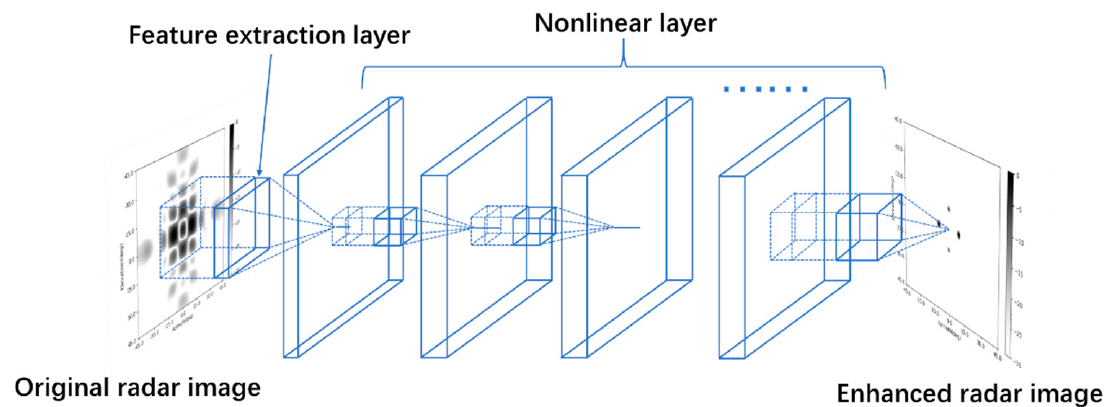
Figure 2. Structure of the conventional radar image-enhancing CNN.